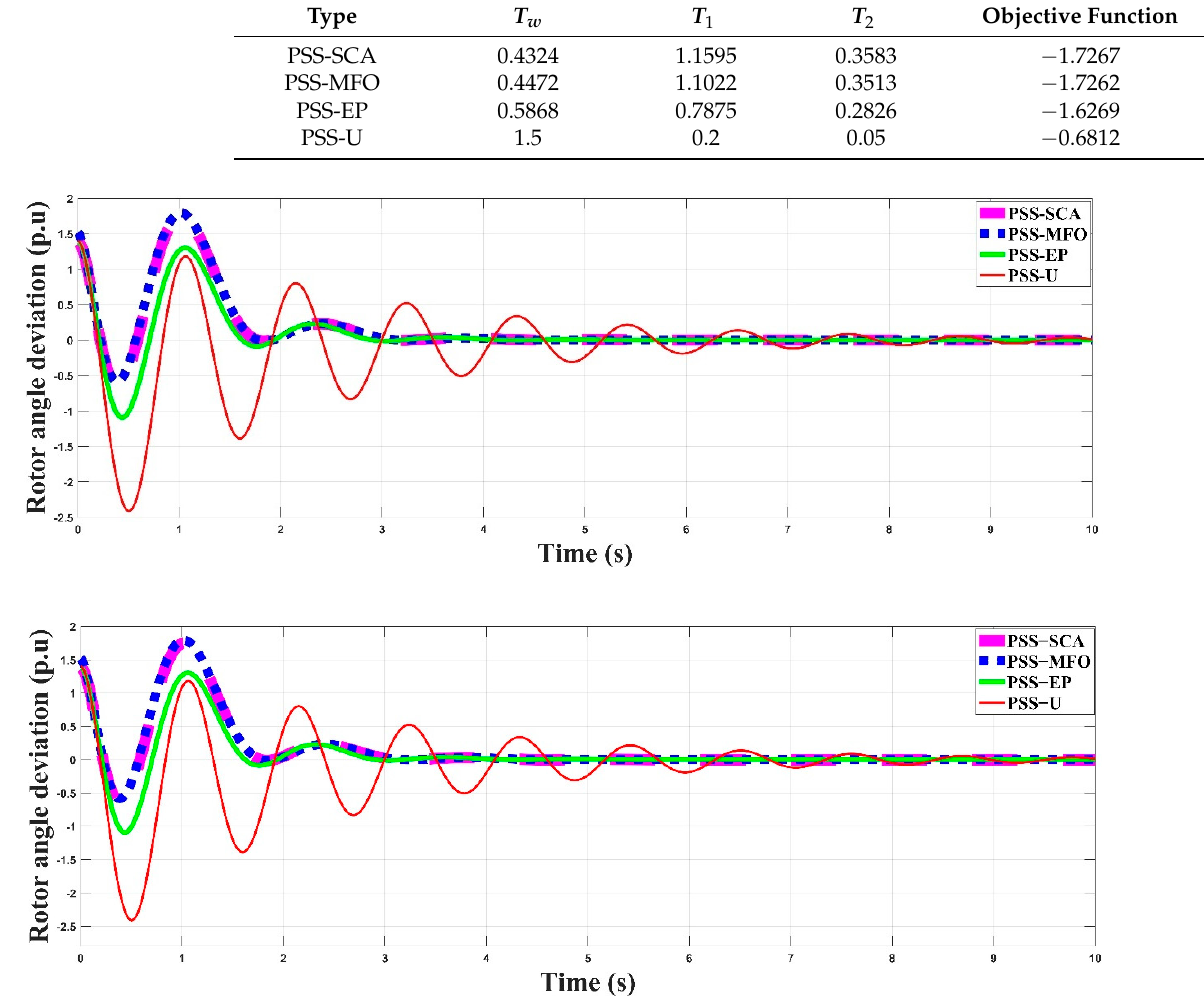
Figure 11. Rotor angle deviation response of PSS-SCA, PSS-MFO, PSS-EP, and PSS-U for case 3. All eigenvalues are on the negative side of the complex s-plane that show the stable condition of all systems for case 3, as shown in Figure 12. The eigenvalue of PSS-SCA is on the left-most of the imaginary axis and is shifted towards the real axis of the s-plane as compared with those of the other techniques PSS-MFO, PSS-EP, and PSS-U.